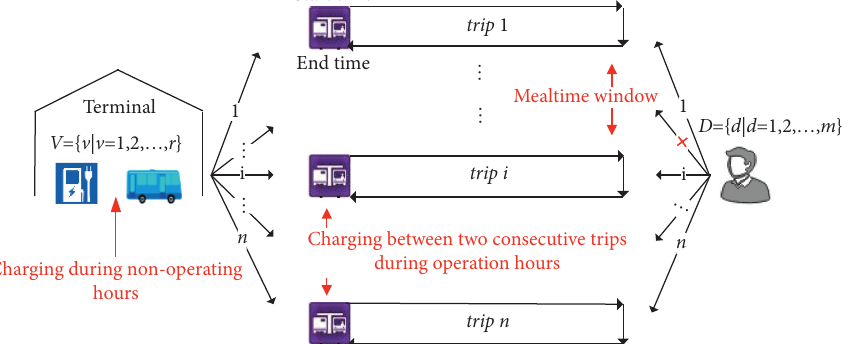
Figure 2: Bus and driver scheduling with charging and mealtime